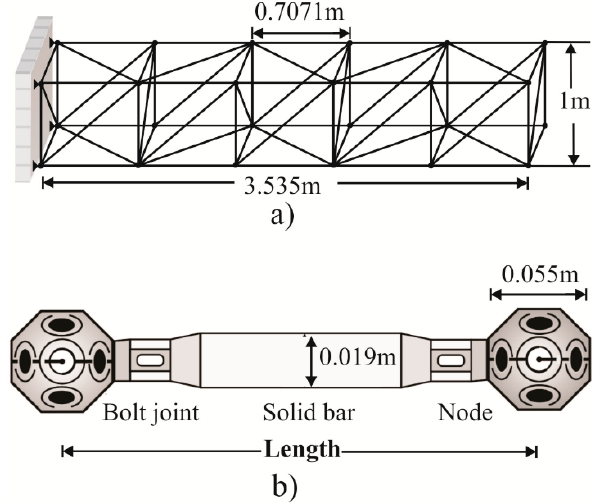
Figure 1. ( a ) Truss structure under test and ( b ) typical assembly of a bar element.